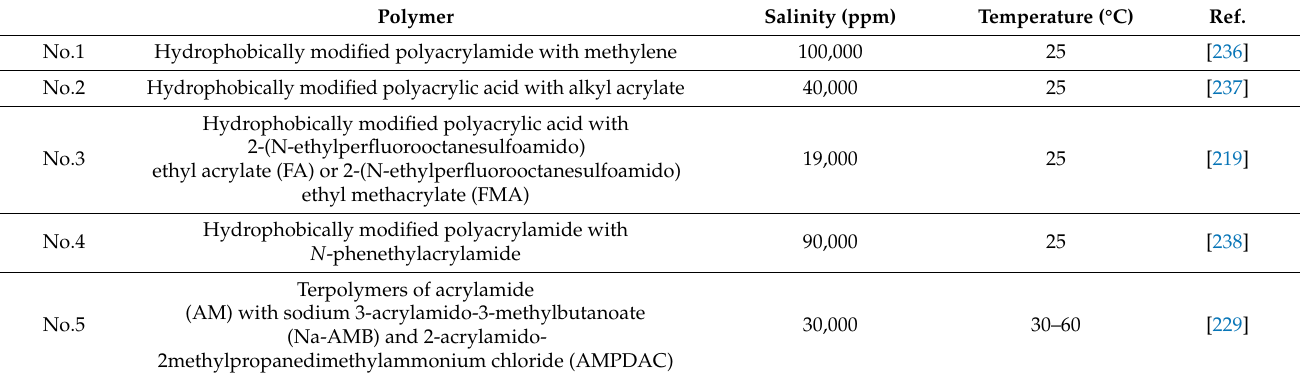
Table 1. Polymers stable at high salinity and/or high